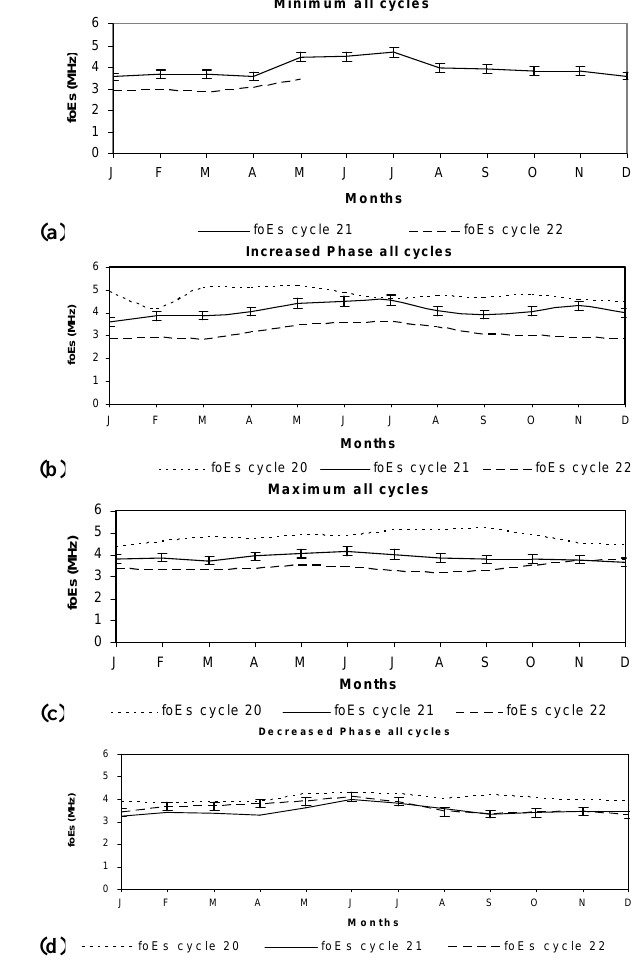
Fig. 5. Similar to Fig. 3 for fo Es.